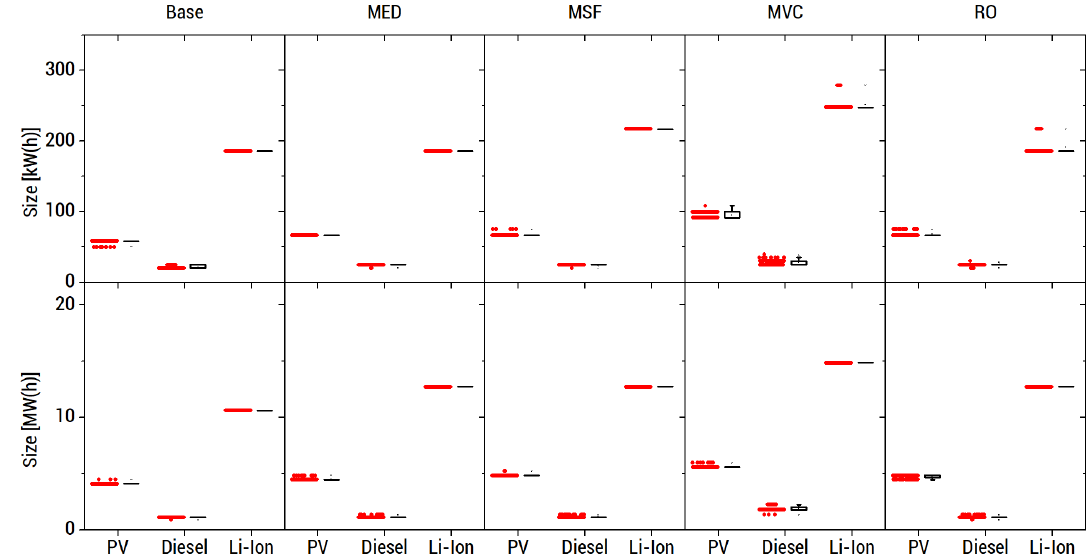
Figure 17. Distribution of optimum LCOE and LCOW on Camasusu Island ( top ) and Lubang Island ( bottom ) at − 25% overnight fuel price. There is minimal uncertainty for these metrics. Energies 2020 , 13 , x FOR PEER REVIEW 15 of 25